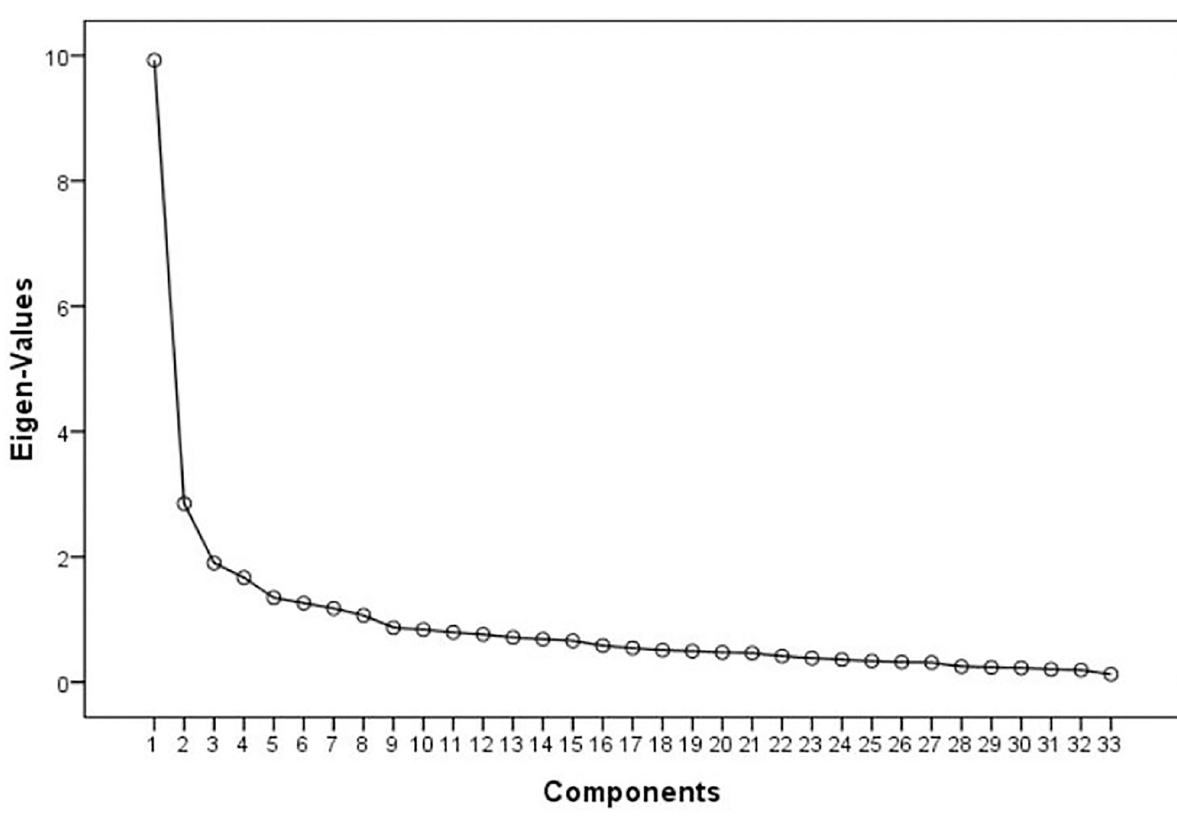
Fig 1. Scree plot of the W-DEQ-A-Sp.